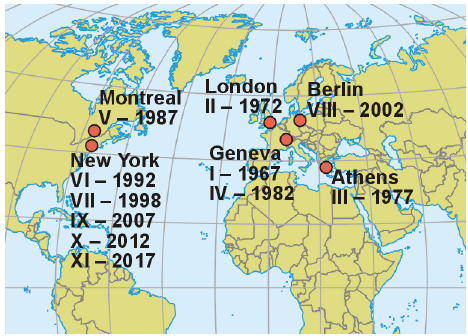
Fig. 1. Locations of United Nations Conferences on the Standardization of Geographical Names (after M.